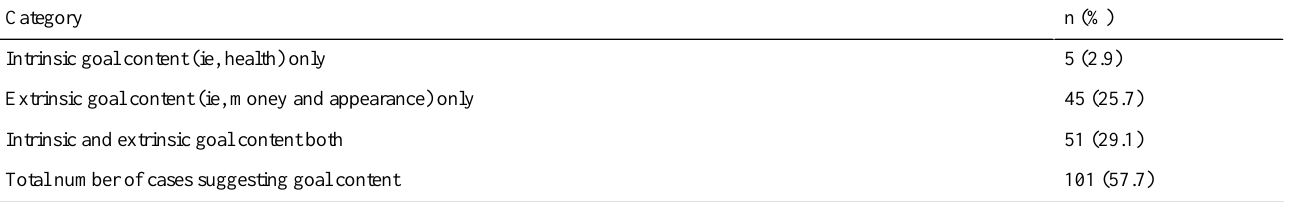
Table 4. Goal content (intrinsic vs extrinsic) of smoking cessation apps available in South Korea (N=175).